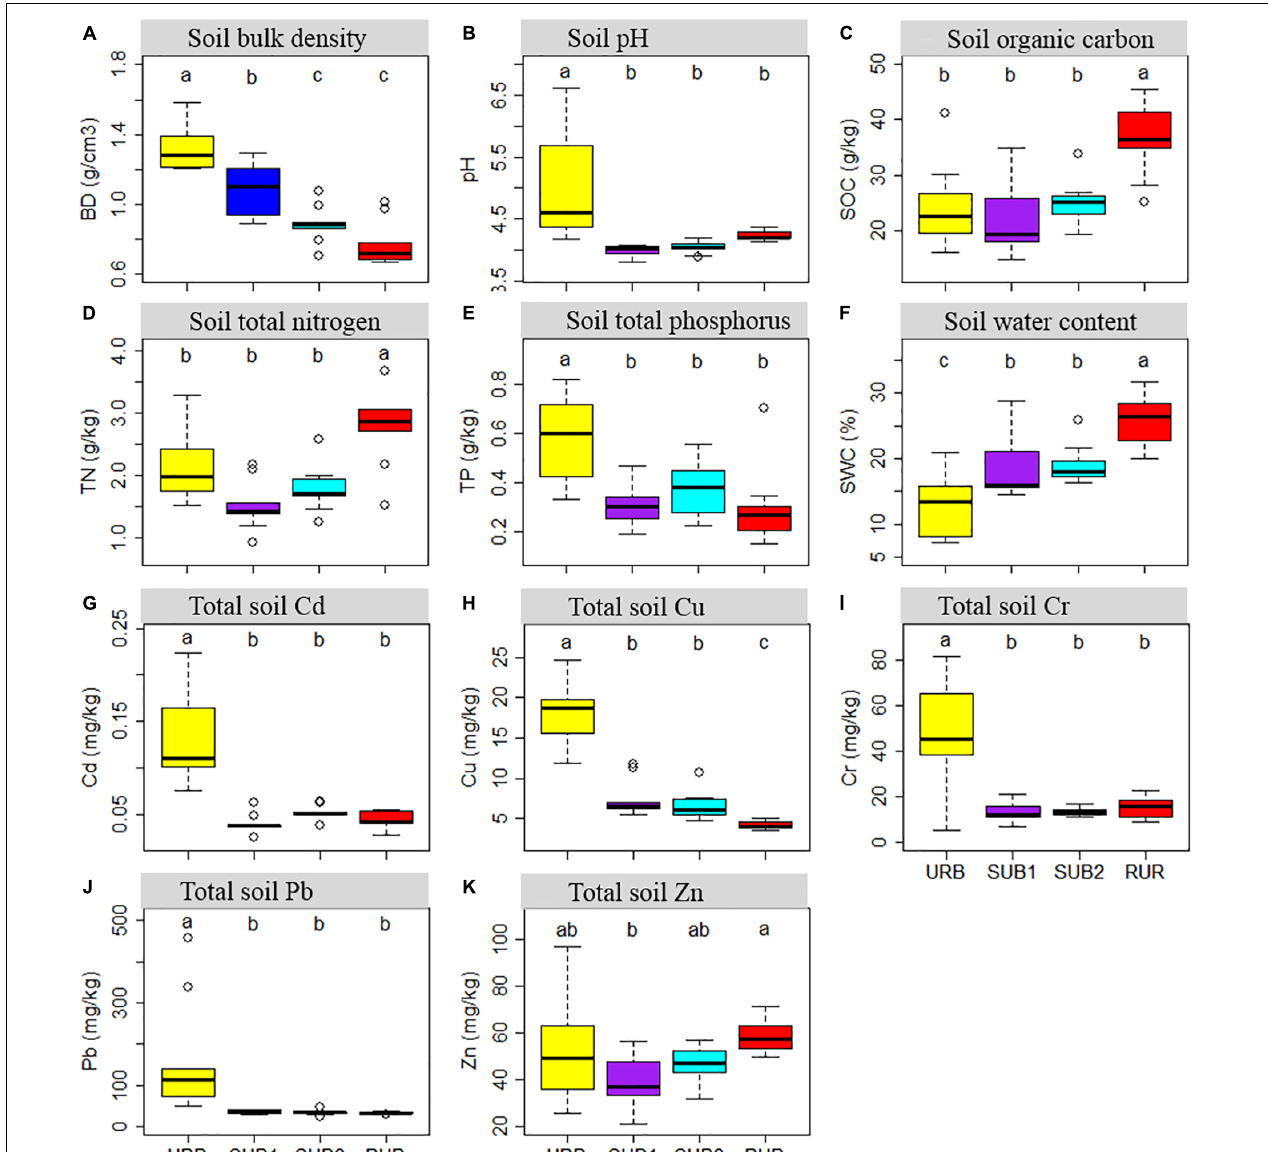
FIGURE 2 | Boxplots showing soil physicochemical characteristic in urbanization gradient sites: (A) Soil bulk density; (B) Soil pH; (C) Soil organic carbon content; (D) Soil total nitrogen content; (E) Soil total phosphorus content; (F) Gravimetric soil water content; (G) Total soil Cd content; (H) Soil total Cu content; (I) Soil total Cr content; (J) Soil total Pb content; (K) Total soil Zn content. The urbanization gradient sites are urban (URB), suburban 1 (SUB1), suburban 2 (SUB2), and rural (RUR) sites. Each boxplot is shown for nine samples. Different letters represent statistically significant differences at p =